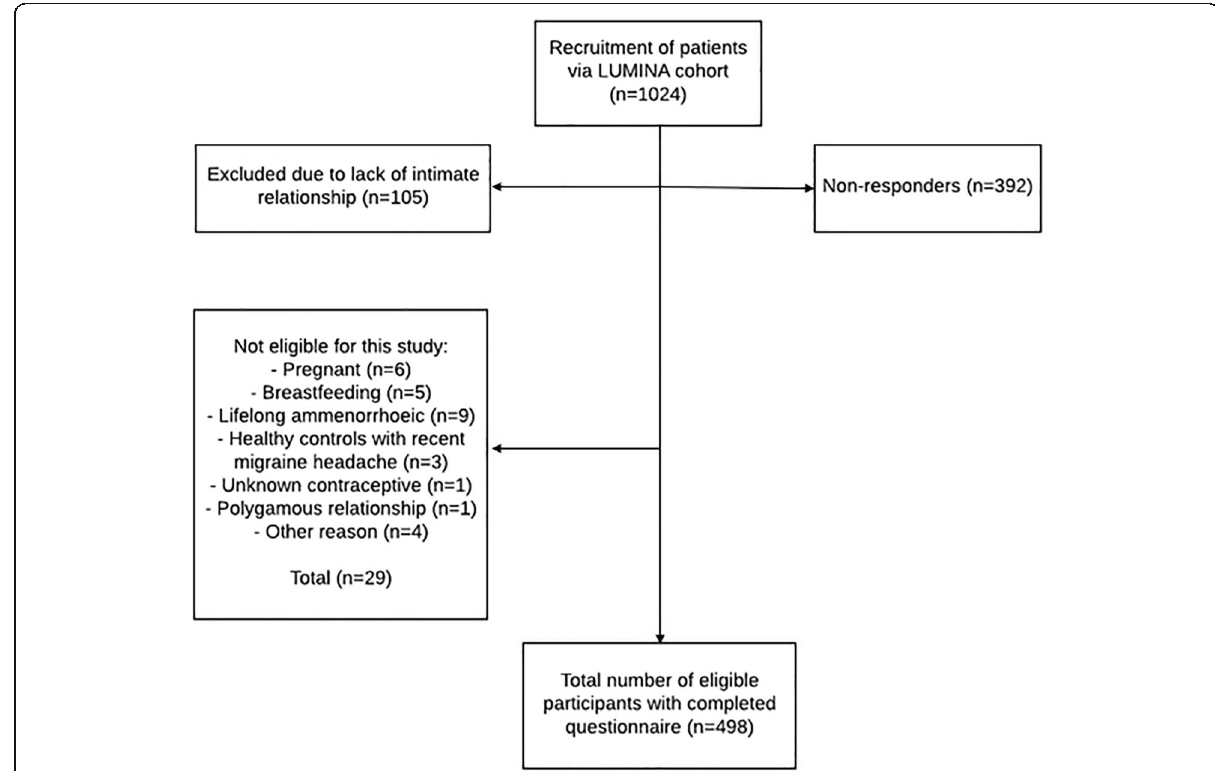
Fig. 1 Flow diagram of recruitment of